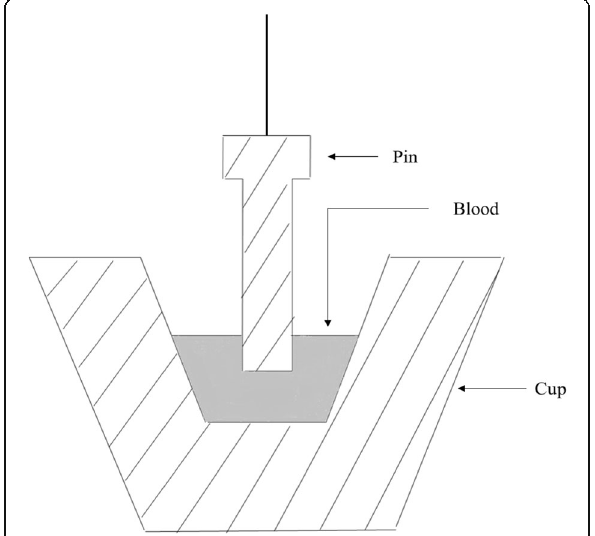
Fig. 1 Thromboelastography mechanism (modified from Donahue and Otto